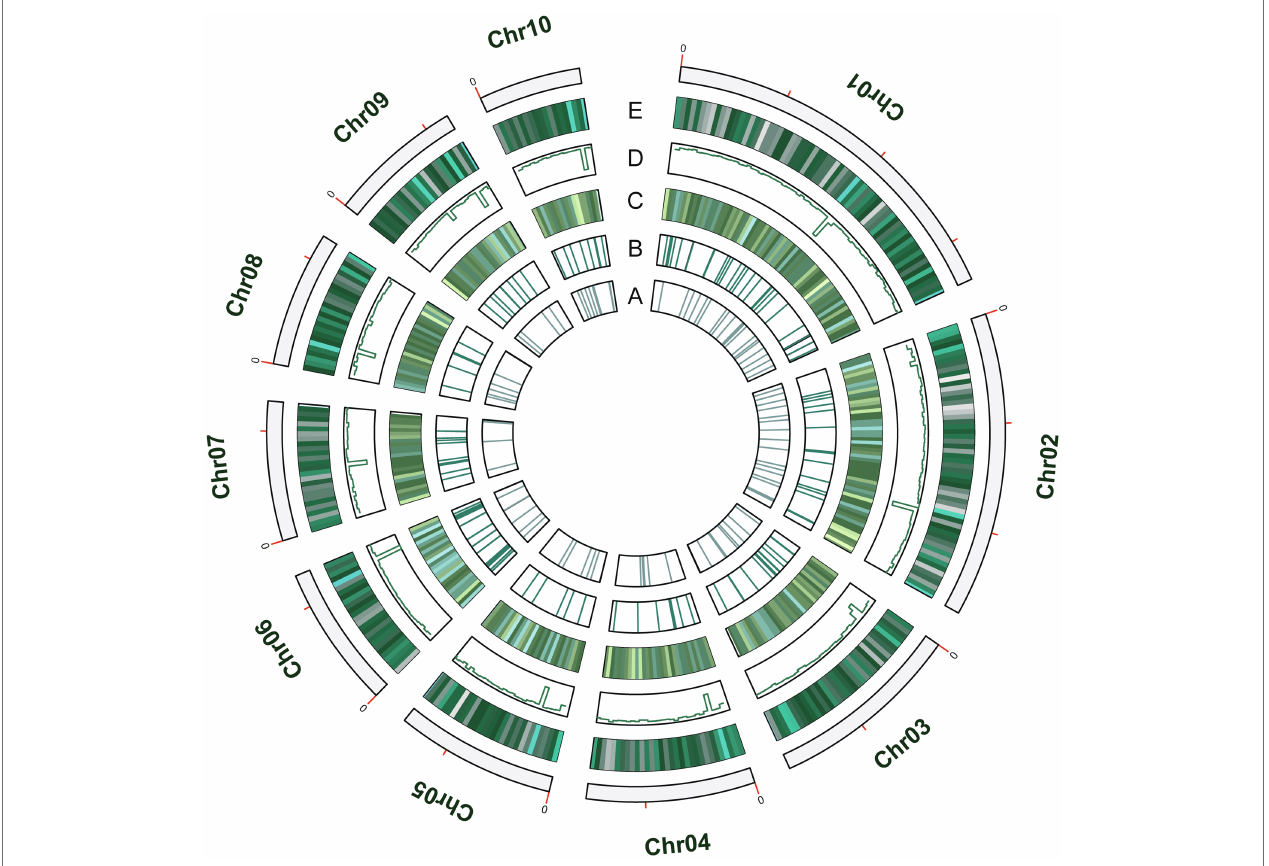
FIGURE 4 | The circos diagram of the A. alternata (Y784-BC03) genome. Y784-BC03. (A–E) represent ncRNA, tRNA, toxins, GC content, and Genes,